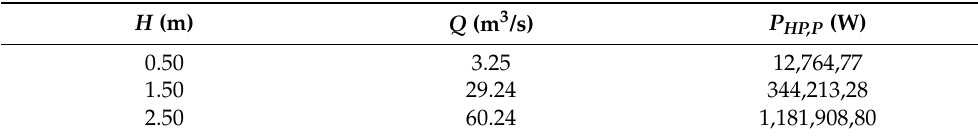
Table 6. Insight into the potential power of the turbines with respect of the potential hydro energy for the Mirna River.